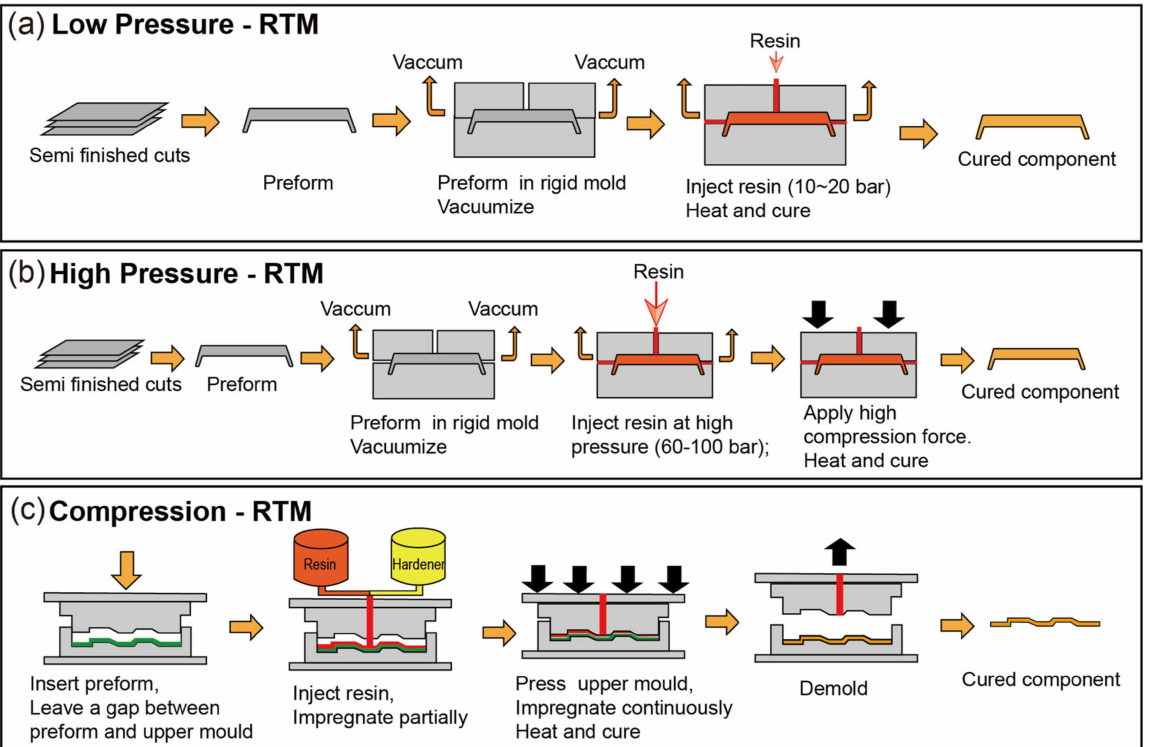
Figure 9. Molding process of variants of RTM (Adapted with permission from Ref. [86]. 2019,